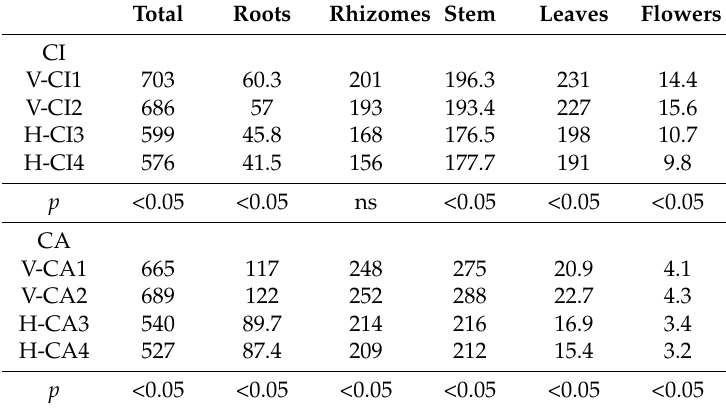
Table 1. Biomass (g DW m − 2 ) of two wetland plants grown at the end of 150 days in the VSFCW and HSFCW belong to the HCW system. Total Roots Rhizomes Stem